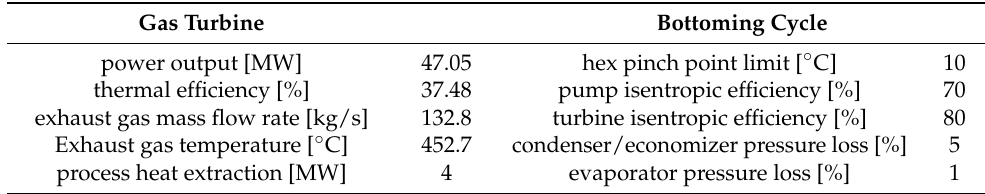
Table 1. Design point performance and conditions.